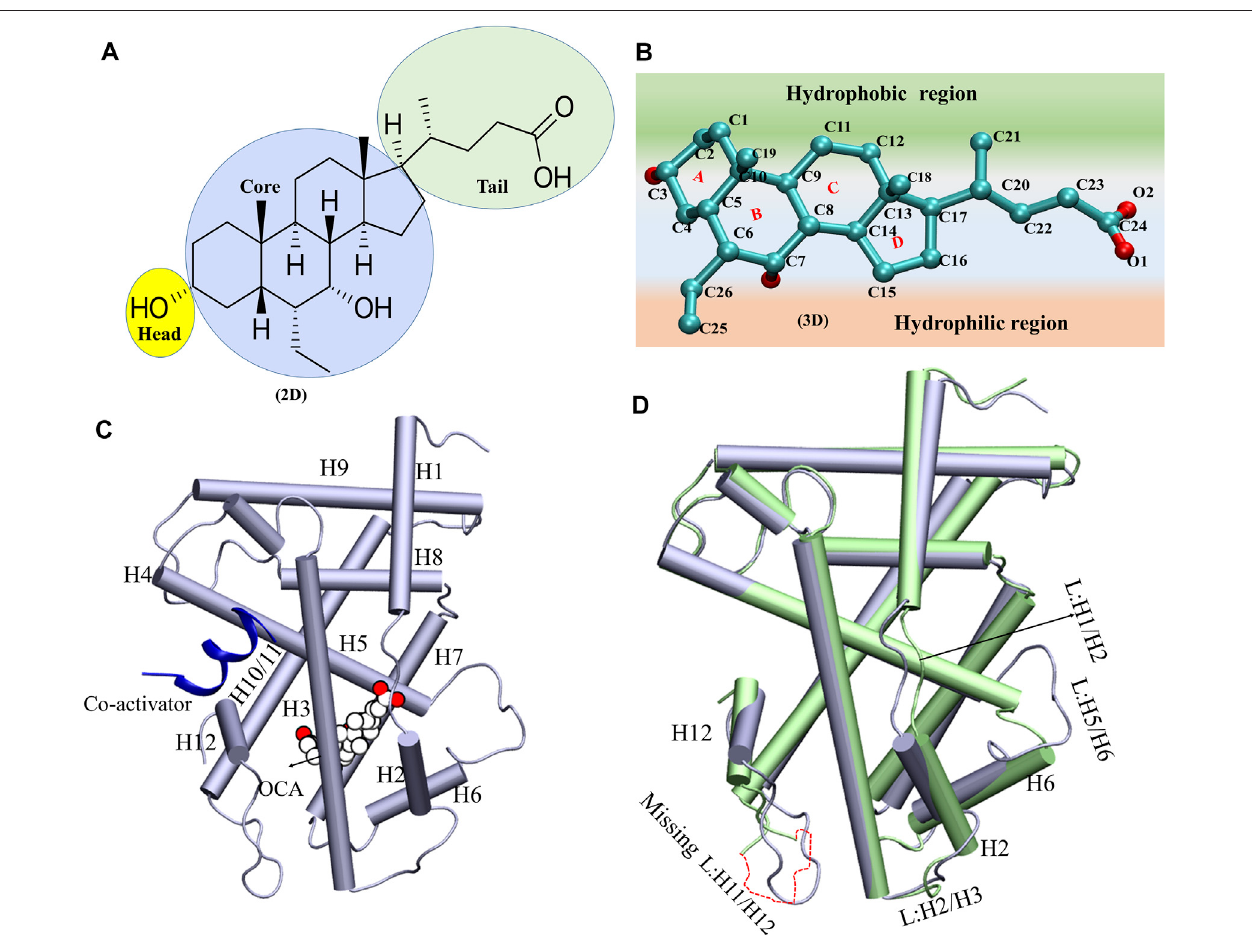
FIGURE 1 | The schematic presentation of the OCA and overlay of the system A and Systems D. (A,B) The 2D and 3D representations of ‘ OCA ’ . The different regions of ‘ OCA ’ were highlighted in different colors. (C) The structure of ligand binding domain of FXR. The binding of ‘ OCA ’ (VDW: white) and ‘ co-activator ’ (cartoon: blue)arehighlighted. (D) ThesuperimpositionofcrystalstructuresofSystemC(PDB:ID5Q0K:inlime)andSystemD(PDB:ID1OSV:iceblue)andinducechangesinthe structure are